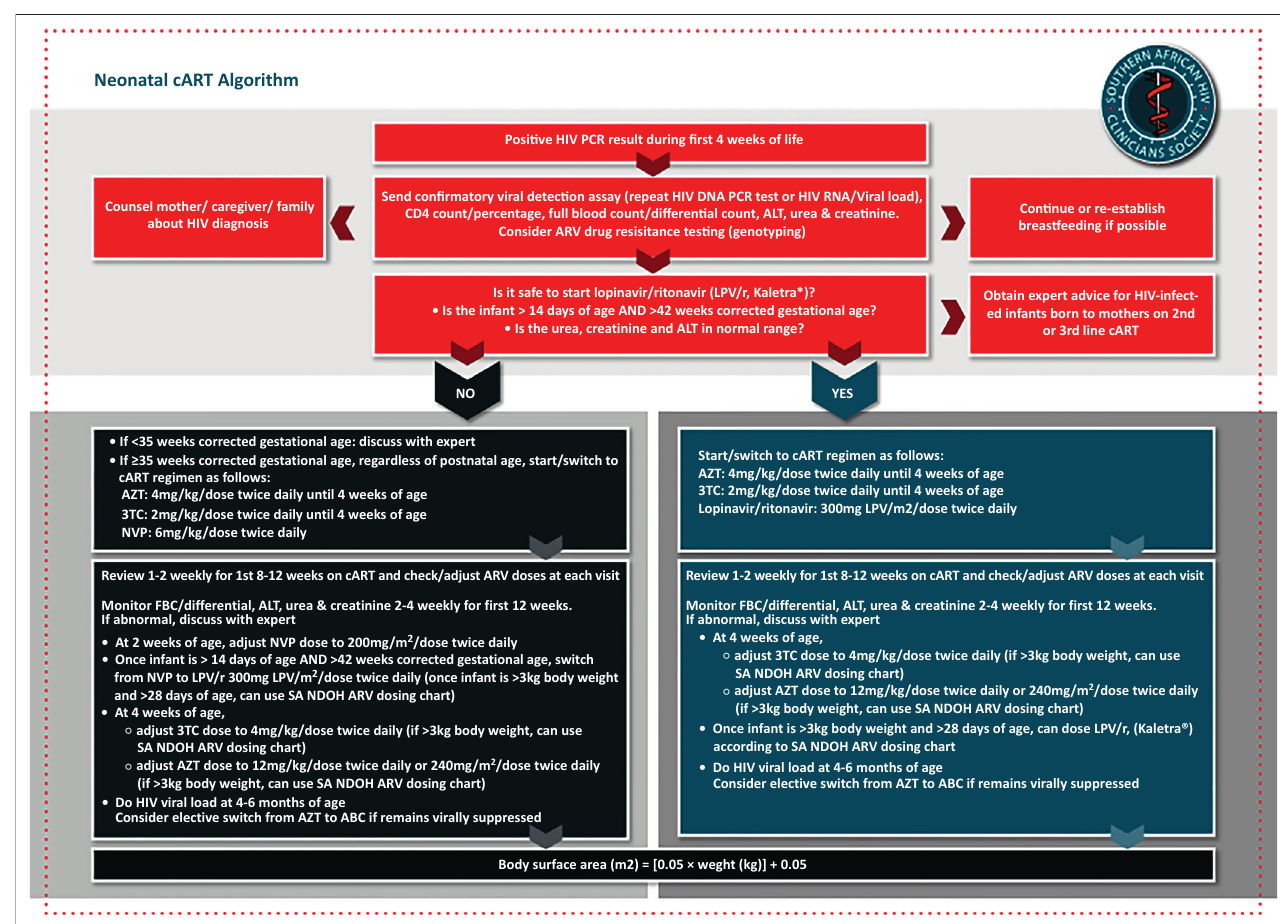
FIGURE 1: Recommended process for initiation of combination antiretroviral therapy in neonates.